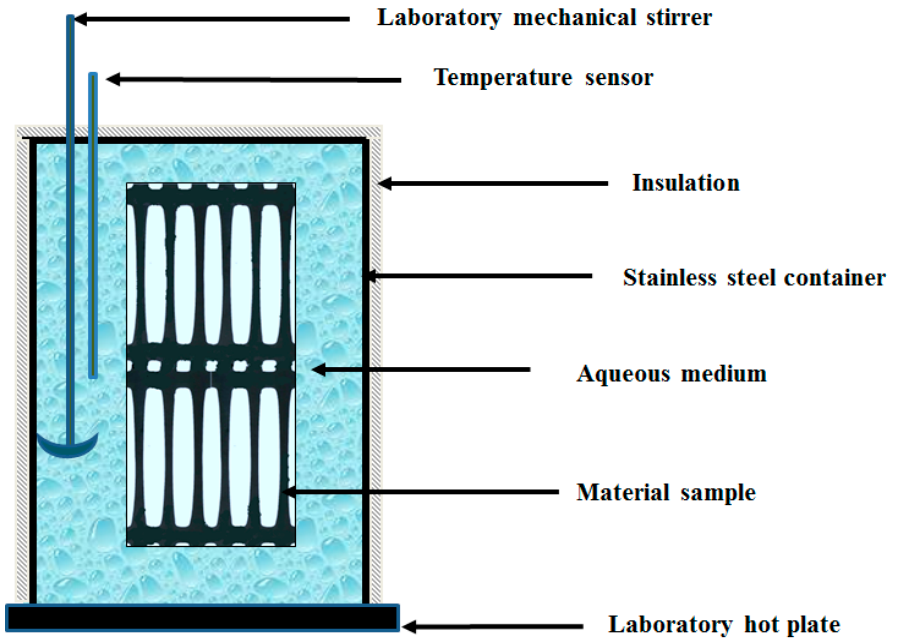
Figure 3. Apparatus employed for accelerated aging evaluations.